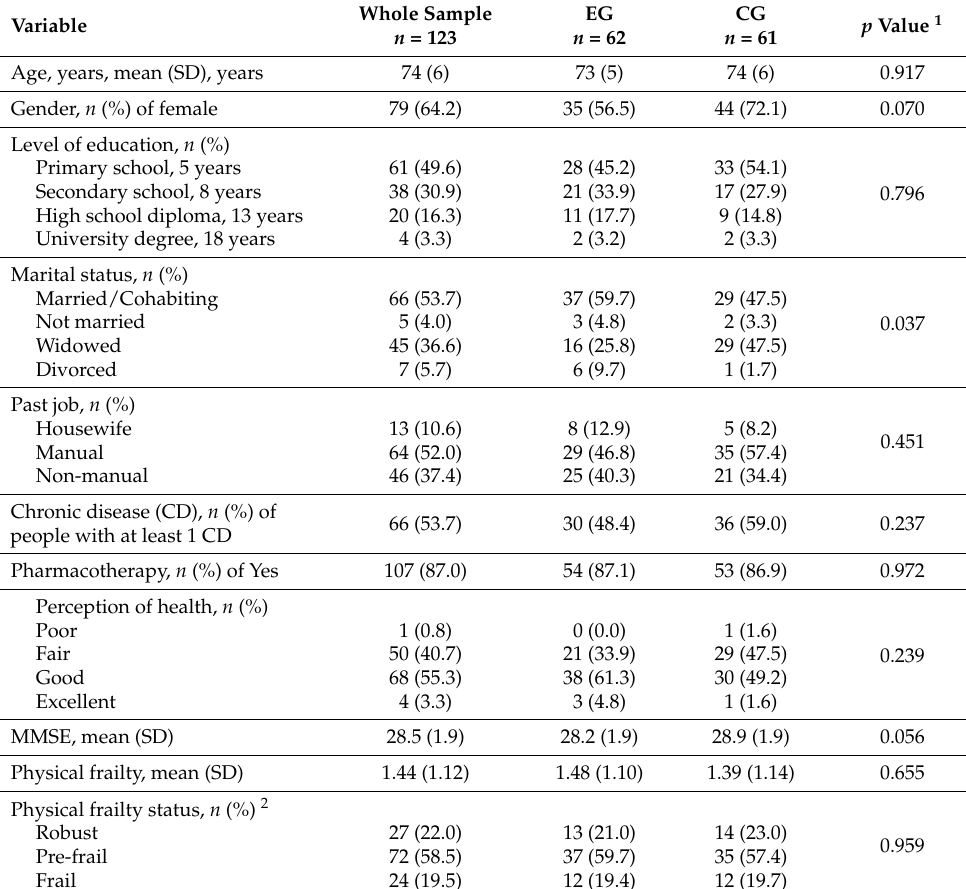
Table 2. Baseline characteristics for the whole sample, the experimental group (EG) and the control group